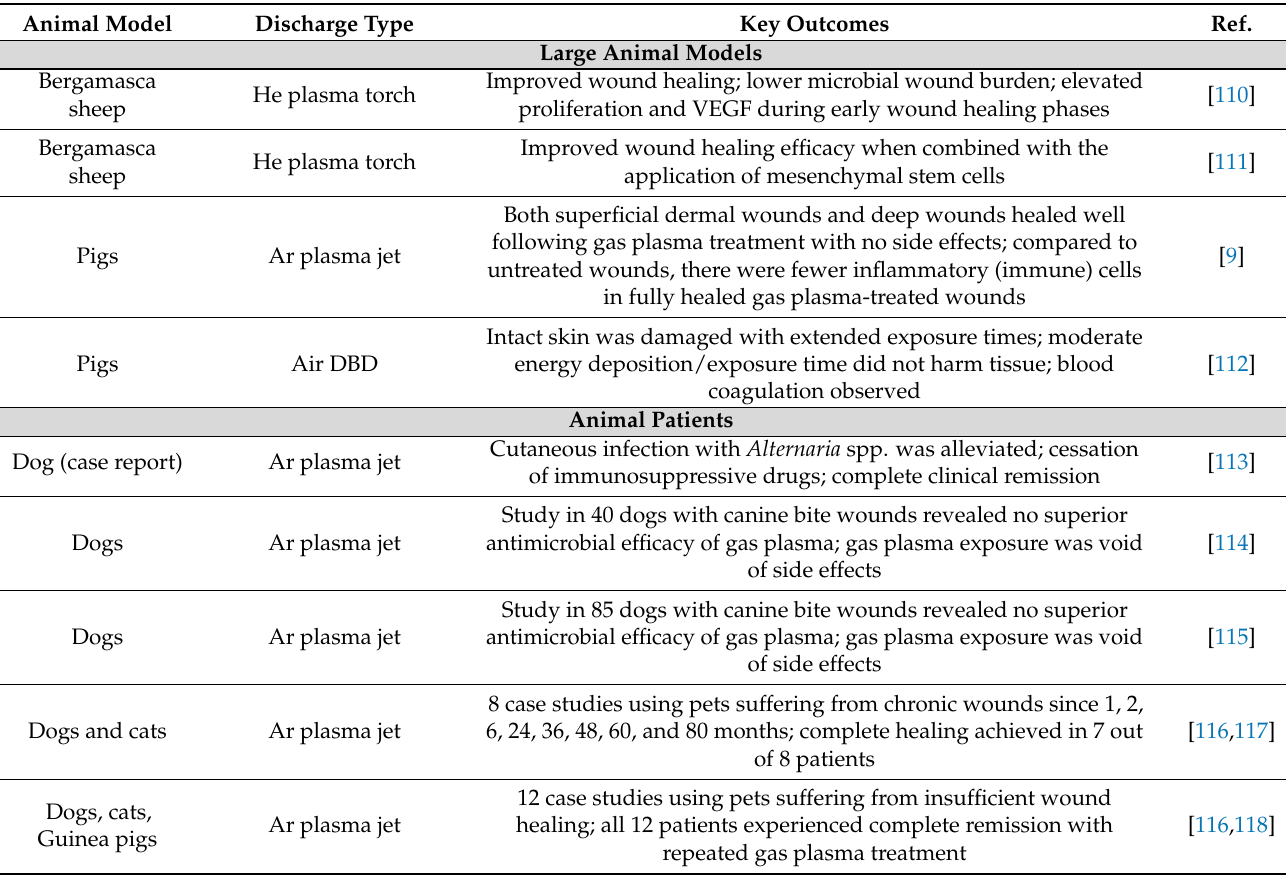
Table 3. Study overview on gas plasma-treated skin and wound healing in other mammals and pet patients. Animal Model Discharge Type Key Outcomes Ref. Large Animal